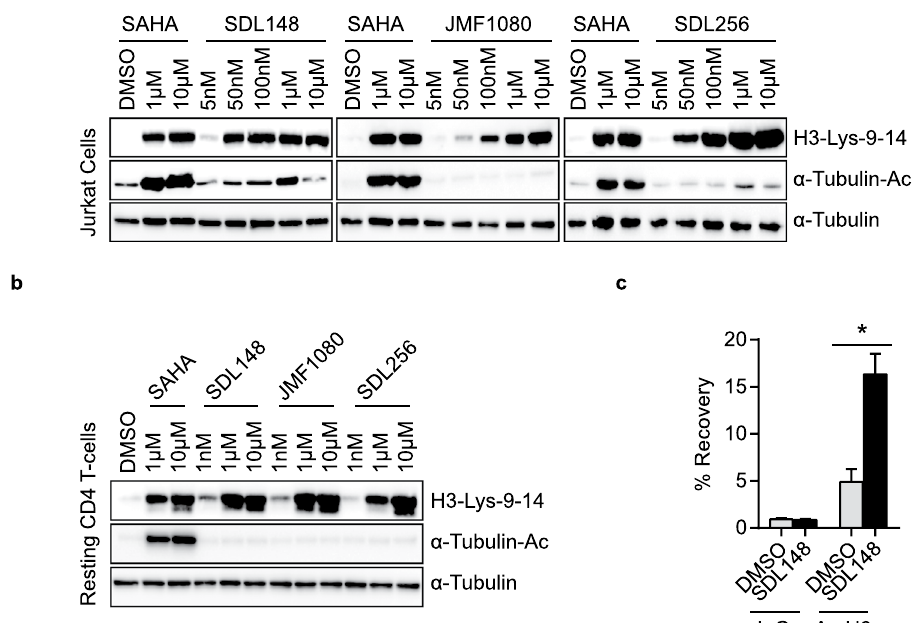
Figure 5. Largazoles are isoform-targeted class I HDAC inhibitors that enhance histone H3 acetylation at the HIV promoter. Largazoles inhibit class I, but not class II histone deacetylases. Compounds at indicated concentrations were incubated with (a) Jurkat or (b) primary T-cells for 8 h and Western blot performed for acetylated histone H3 (a marker of class I HDAC inhibition) or acetylated tubulin (a marker for HDAC6, a class II HDAC) inhibition. (c) Chromatin immunoprecipitation (ChIP) of acetylated histone H3 and HIV LTR promoter. JLAT10.6 cells were incubated with DMSO or 1 μ M of SDL148 for 6 h and ChIP performed as described in Methods. Data indicate mean values and error bars indicate mean ± s.e.m. (n ≥ 3). * p < 0.05, (Student’s t -test). See also Supplementary Fig.